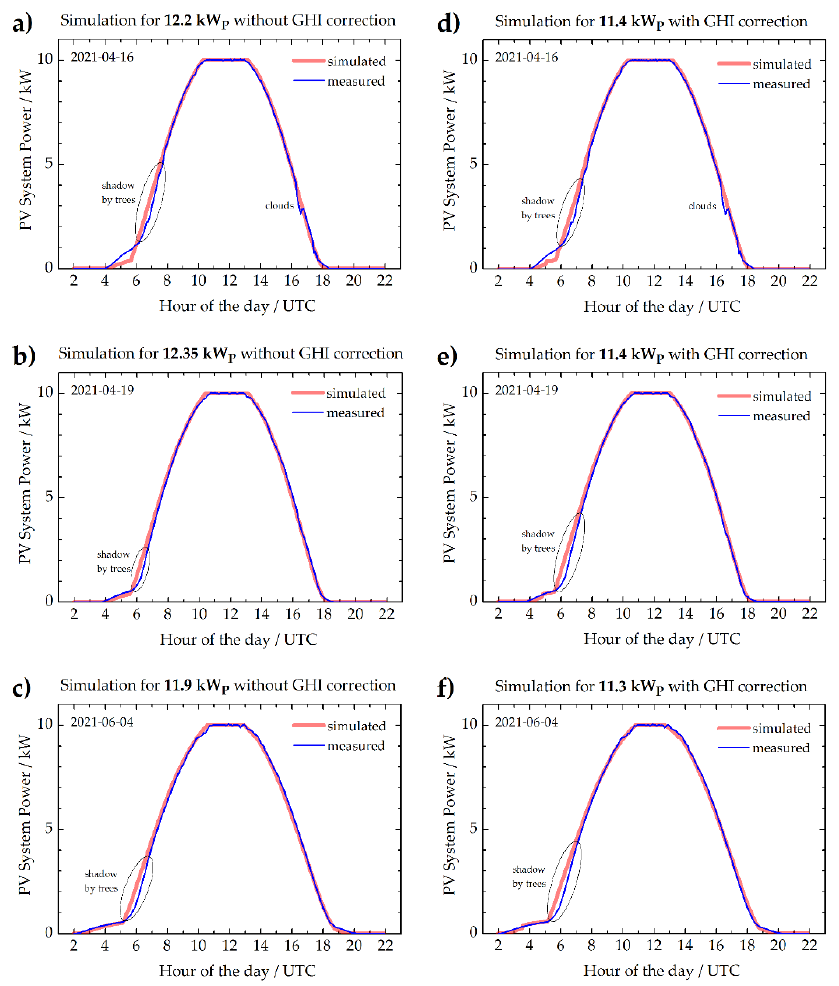
Figure 4. Left column ( a – c ): Simulated and measured system power on three different days. The simulated curves using measured temperatures and wind speed, but without using measured GHI data, were fitted to the measured curves by adjusting the system peak power value to 12.2, 12.35, and 11.9 kW p . Right column ( d – f ): Simulated and measured system power on corresponding days, using temperature, wind speed, and measured GHI data by adjusting the system peak power value to 11.4 and 11.3 kW p . All power values were limited to 10 kW, which is the maximum inverter power. The simulations were done without shallow angle reflection correction (see Section